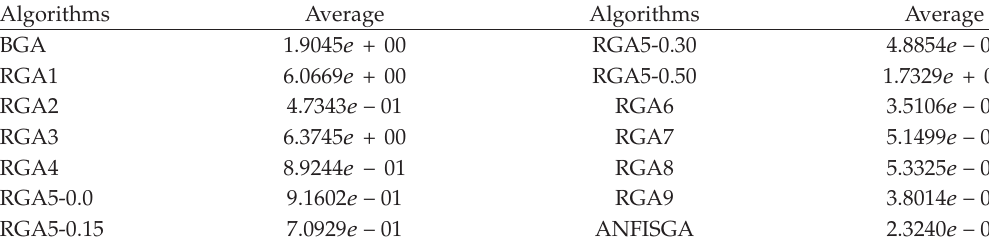
Table 3: Comparison of GAs with